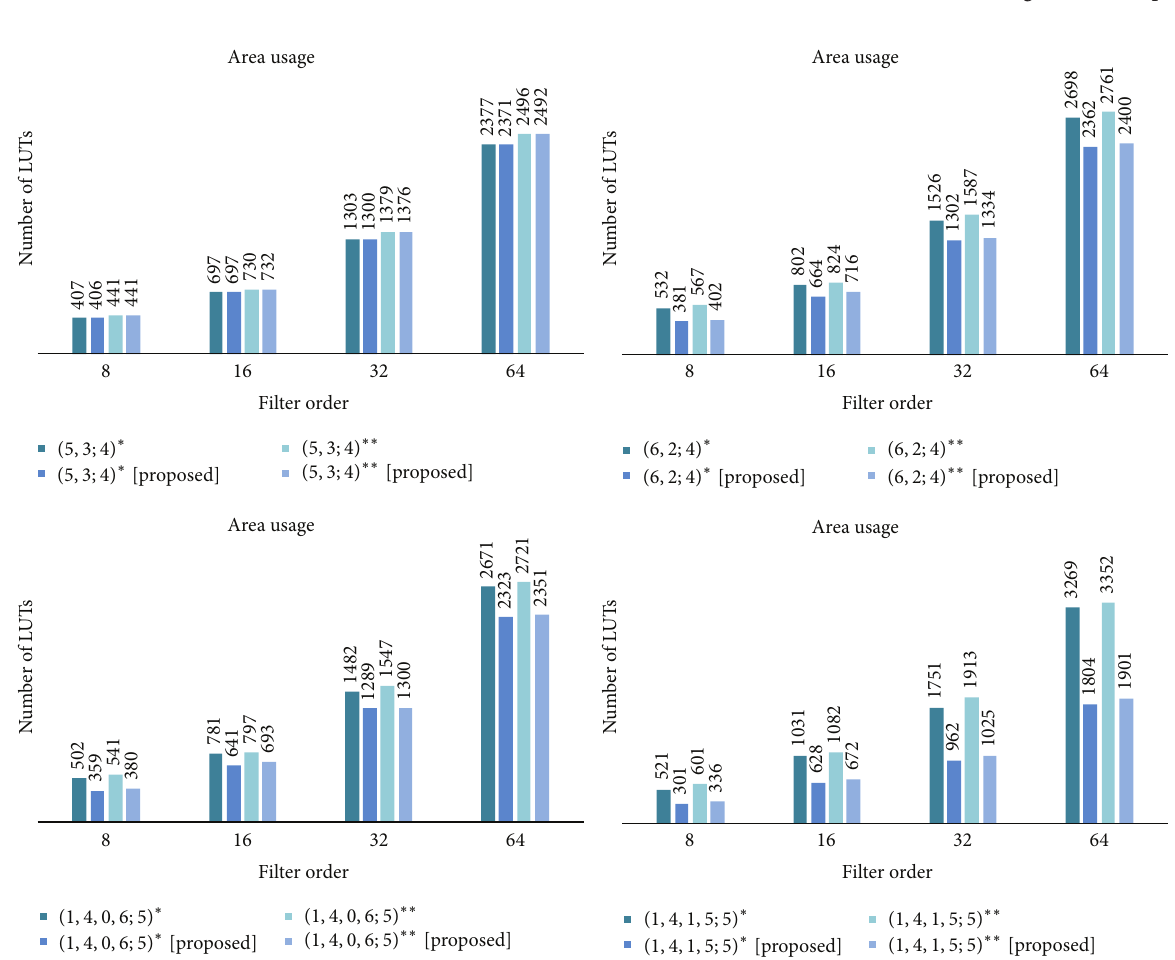
Figure 14: Area usage for filters based on different GPCs on Kintex-7 FPGA. ∗ with area as optimization goal. ∗∗ with speed as optimization